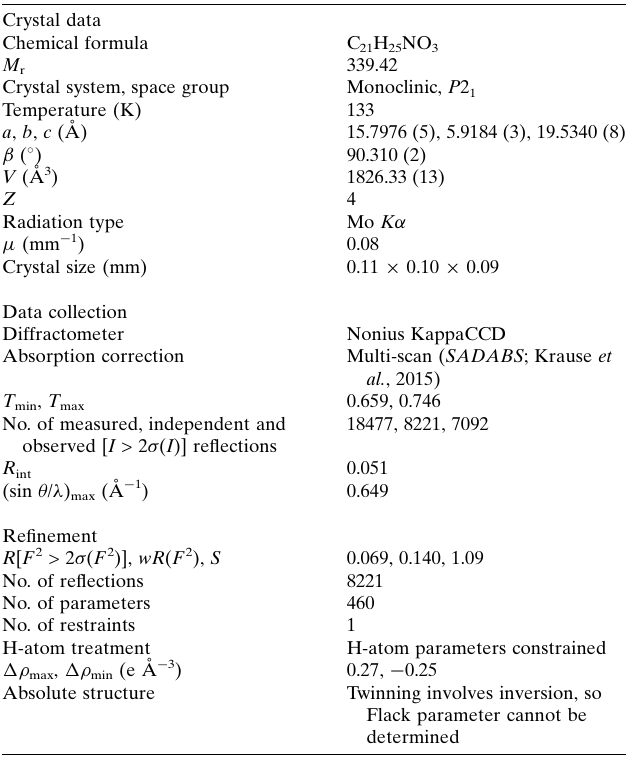
Table 2 Experimental details. Crystal data Chemical